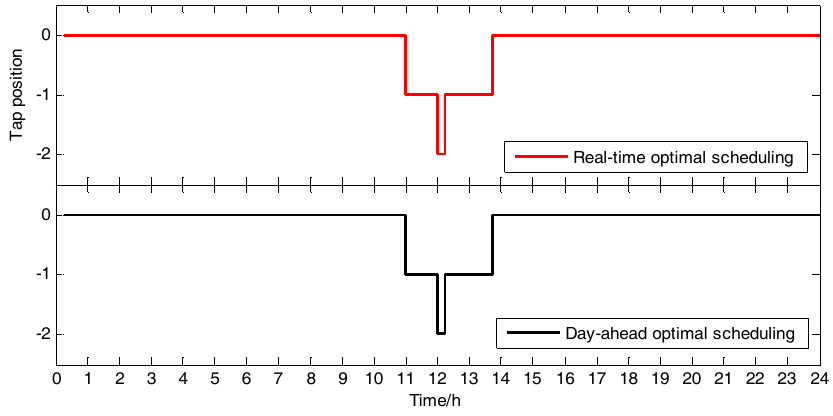
Figure 9. Optimal OLTC tap position for 16 July 2014.